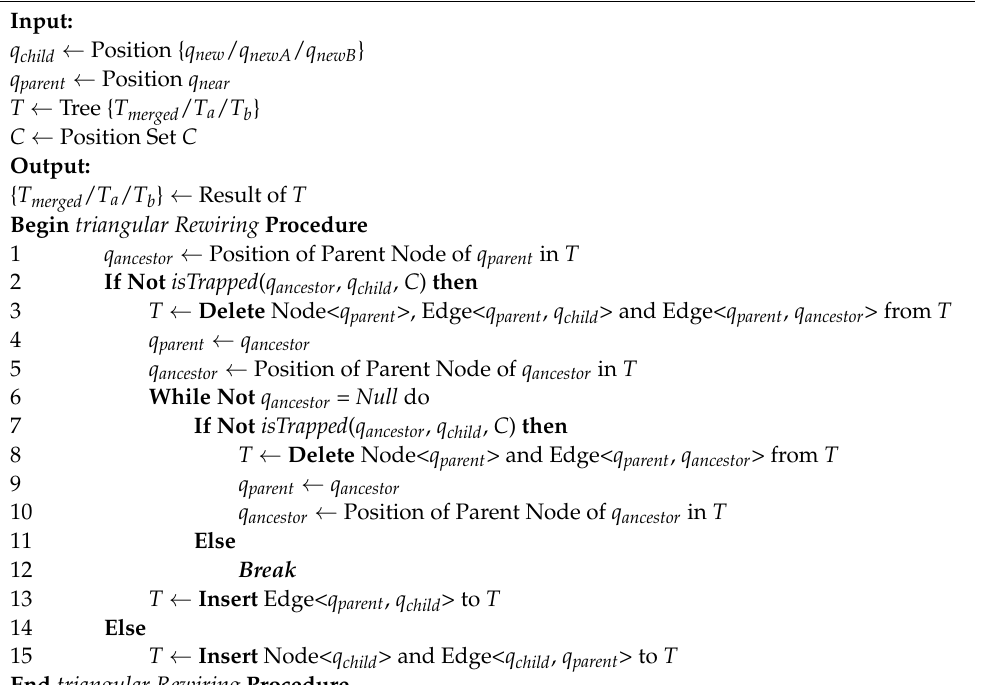
Algorithm 2 Pseudocode of Triangular Rewiring Method for RRT